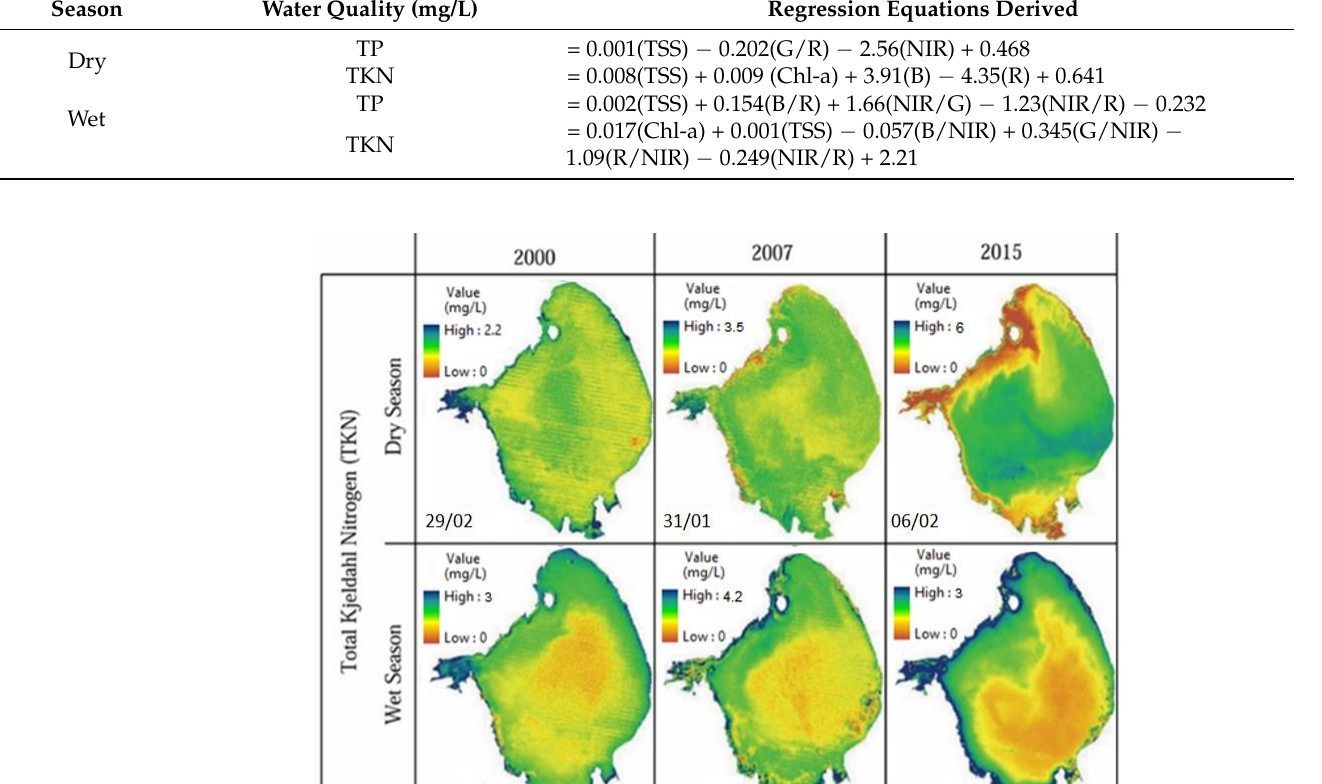
Table 7. Regression equations for TP and TKN, as a function of Landsat bands and other water quality parameters. Season